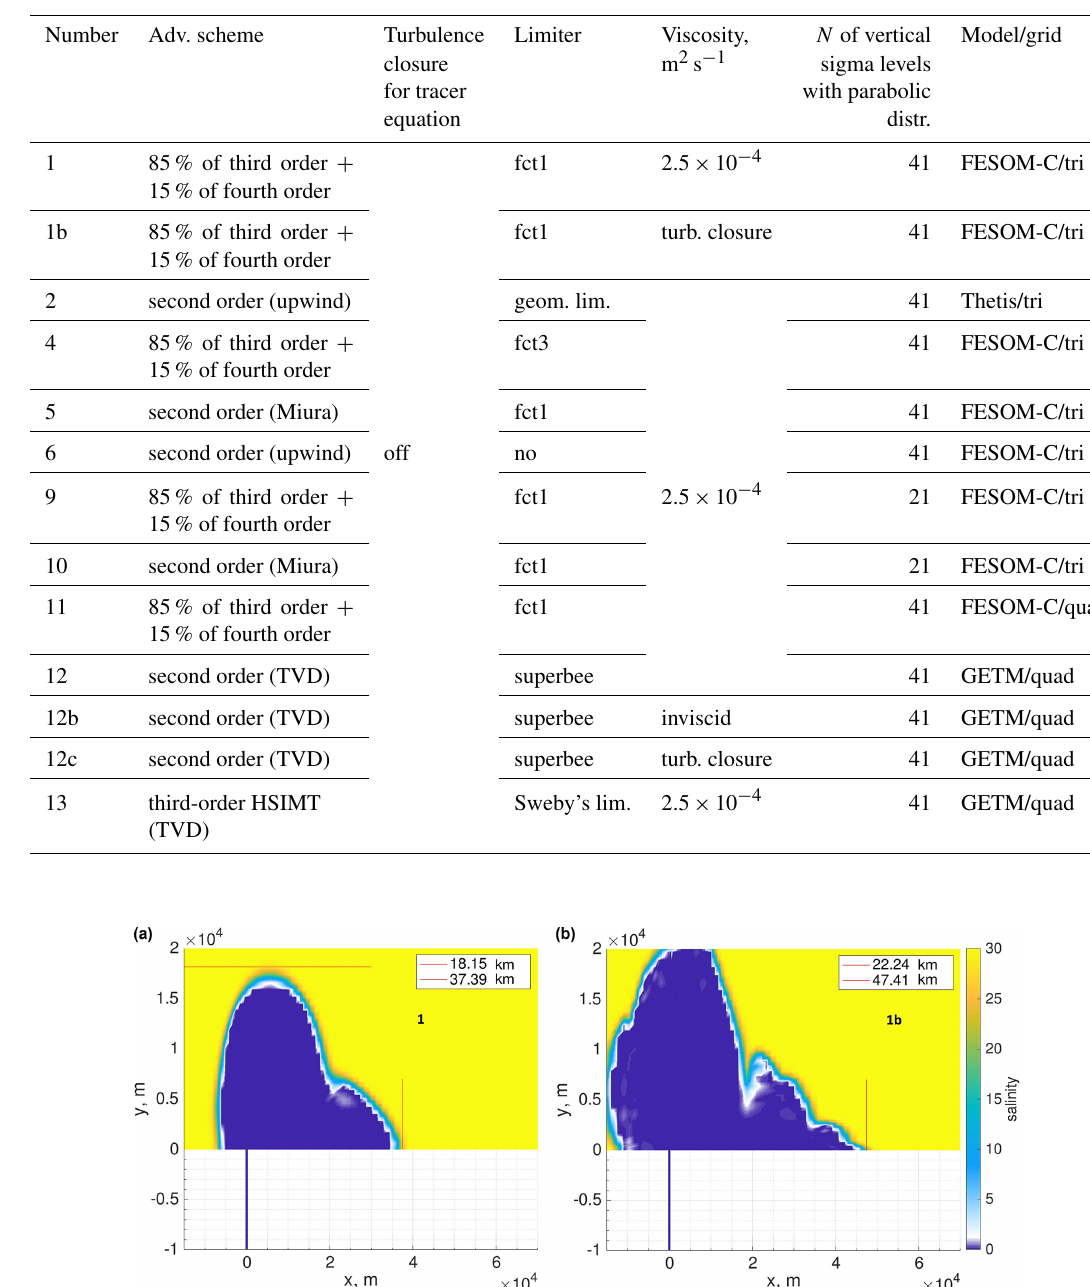
Table A1. The description of the additional runs; the discharge is equal to 3900m 3 s − 1 (other setup details are the same).